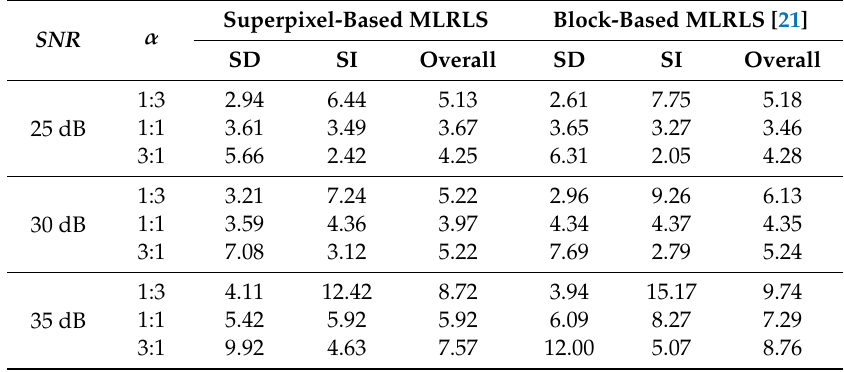
Table 6. The optimal relative errors of the SD noise, the SI noise and the overall optimization for 1:4 spatial subsampling